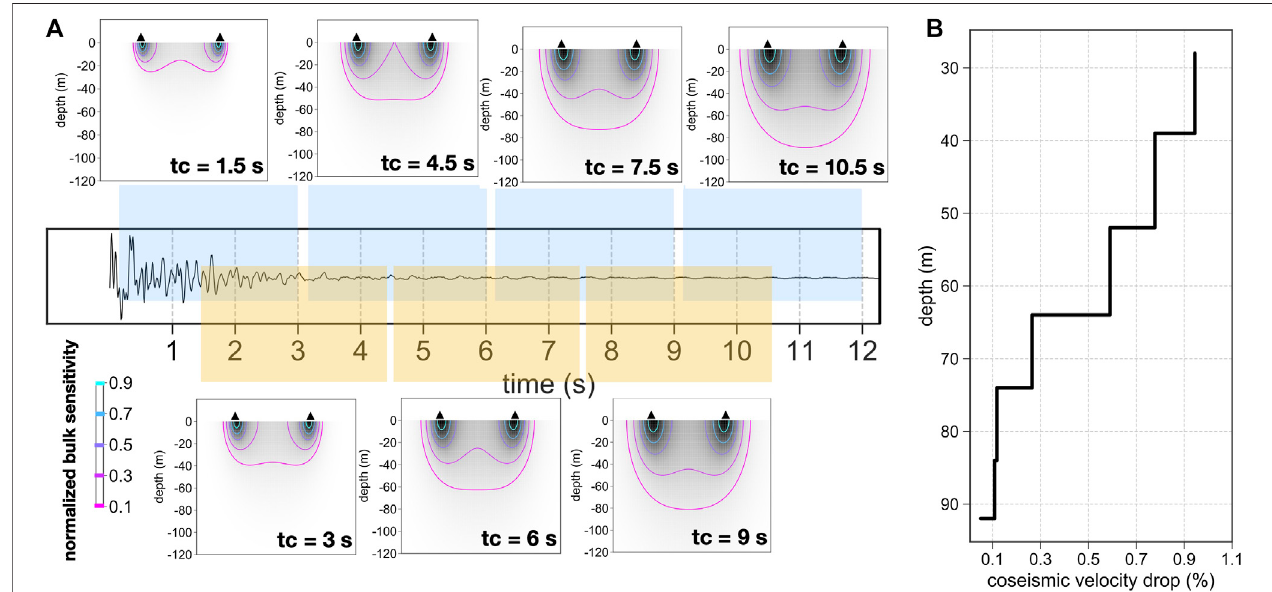
FIGURE6|(A) Numerical modelingofthedepthresolutionofcodawavesmeasured atdifferenttime lapsesofthecoda. (B) Kernel depthsensitivity valuesgreater than 10% as a function of measured co-seismic velocity reduction at each lapse time.